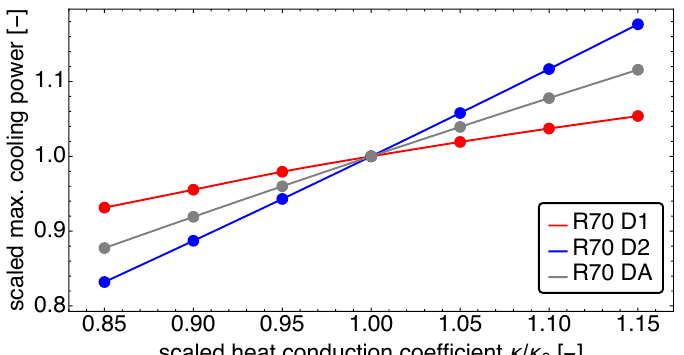
Figure 12. The rescaled maximum cooling power is shown as function of the rescaled heat transport coefficient for the three engine designs D1, D2, and DA, and r = 0.7 regeneration extent. The rescaling is with respect to the properties of the maximum cooling power operating point for the base case.